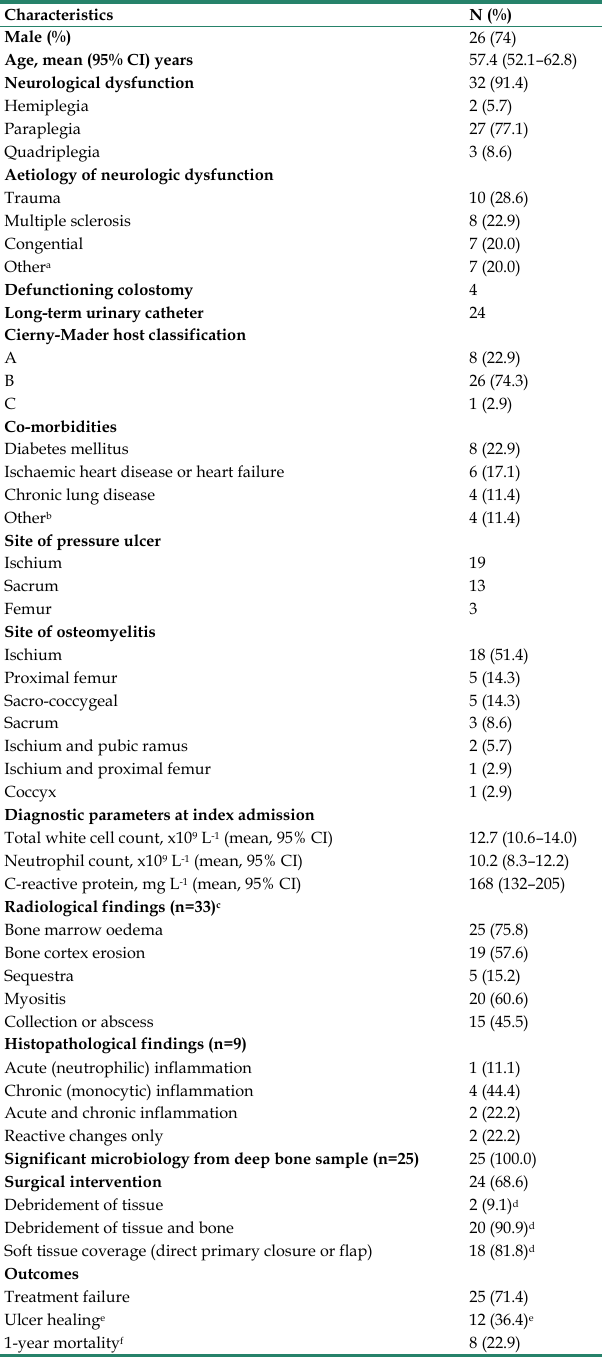
Table 1. Characteristics of included patients with pressure ulcer-related pelvic osteomyelitis (n = 35) Characteristics